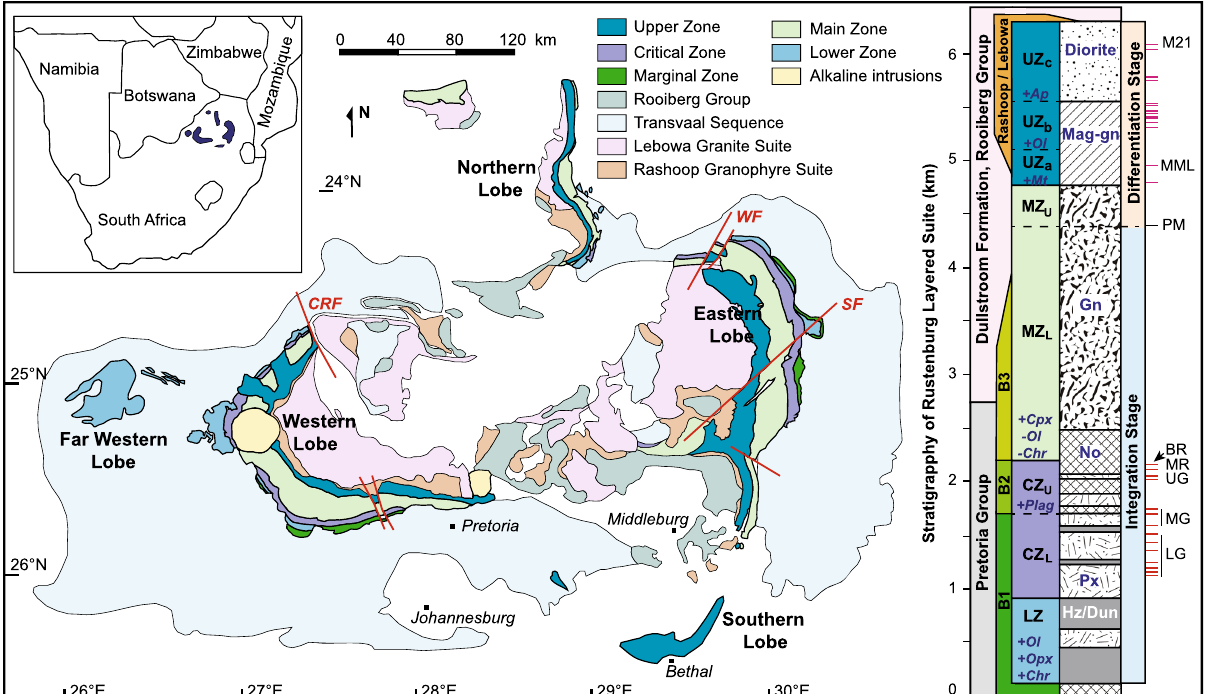
Fig. 2 Geological map of the Bushveld Complex and stratigraphic column of the Rustenburg Layered Suite. Adopted from multiple sources cited in the text 4,12,24,33,44 . Inset map shows the location of the Bushveld Complex within South Africa. Because the RLS is discordant with the underlying footwall rocks, its position within the host rock series varies from the base of the Pretoria Group in the north to the lower Rooiberg Group in the south. In addition, a small segment of the Main-Critical Zones occurs at higher stratigraphic levels near the Steelpoort fault, overlying the Dullstroom Formation of the Rooiberg Group. Marker horizons: LG lower group chromitites, MG middle group chromitites, UG upper group chromitites, MR Merensky Reef, BR Bastard Reef, PM Pyroxenite Marker, MML main magnetite layer, M21 magnetite layer 21. Abbreviation: LZ Lower Zone, CZ L Lower Critical Zone, CZ U Upper Critical Zone, MZ L Lower Main Zone, MZ U Upper Main Zone, Ol olivine, Opx orthopyroxene, Cpx clinopyroxene, Chr chromite, Plag plagioclase, Mt magnetite, Ap apatite, Hz harzburgite, Dun dunite, Px pyroxenite, No norite, Gn gabbronorite, Mag-gn magnetite gabbronorite, CRF Crocodile River Fault, SF Steelpoort Fault, WF Wonderkop